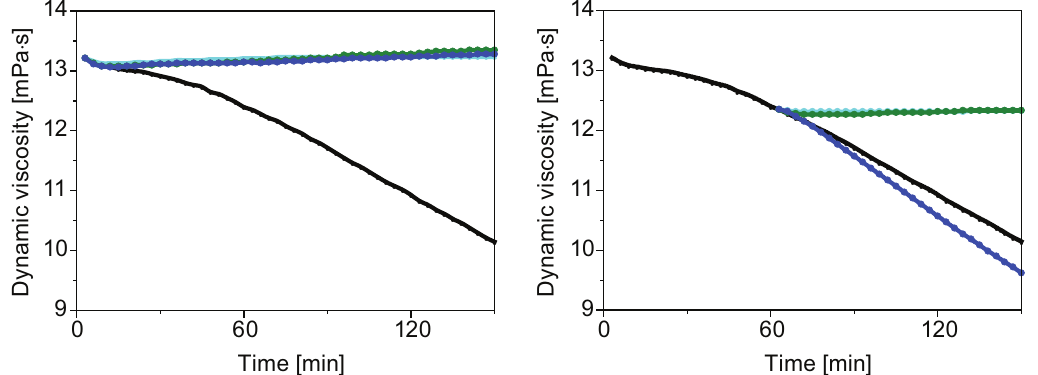
Figure 4. Time-dependent changes in dynamic viscosity of HA solutions exposed to oxidative degradation initiated by Cu(II) ions and ascorbate (black curve). Isatin was added to the HA reaction mixture before HA degradation begins (left panel) and 1 h later (right panel) at micromolar concentrations: 100 (cyan), 10 (green) and 1